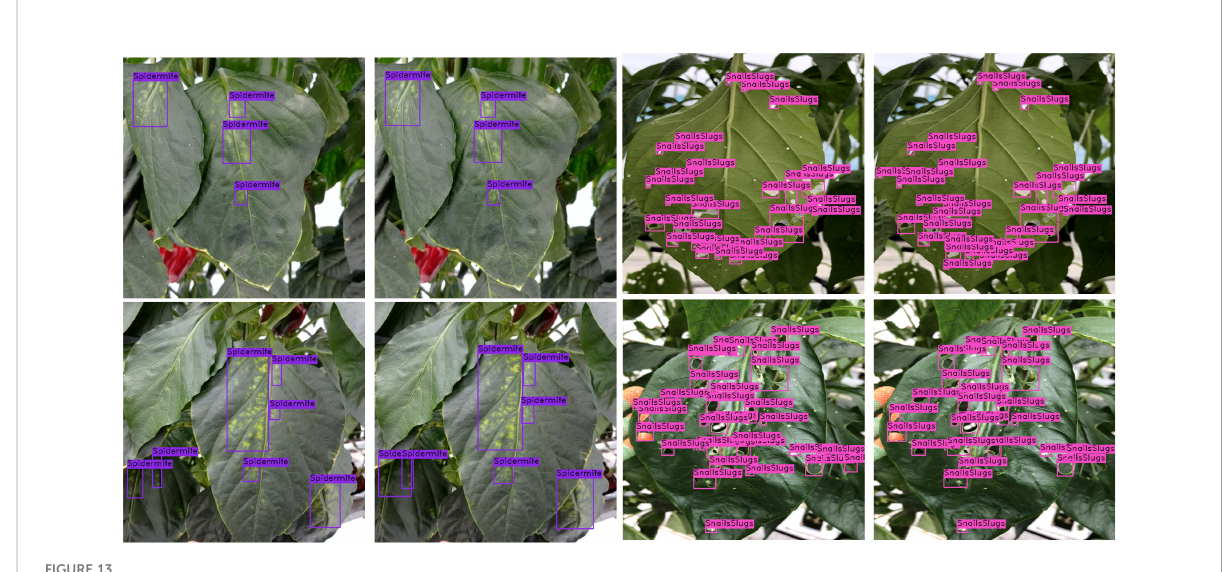
FIGURE 13 Visual results of DIANA in case only insect of pest damage is